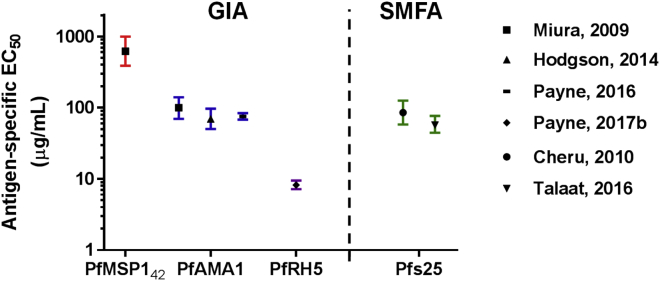
Functional Analysis of Human Antigen-Specific IgGReported EC50 [±95% CI] data from Phase Ia clinical trials of vaccine-induced human antigen-specific IgG, as assessed for functional activity against blood-stage (GIA) or sexual-stage parasites (SMFA). Vaccine-induced polyclonal IgG responses are carefully quantified using affinity-purified ELISA standards (Cheru et al., 2010, Miura et al., 2009) or calibration-free concentration analysis (Hodgson et al., 2014).